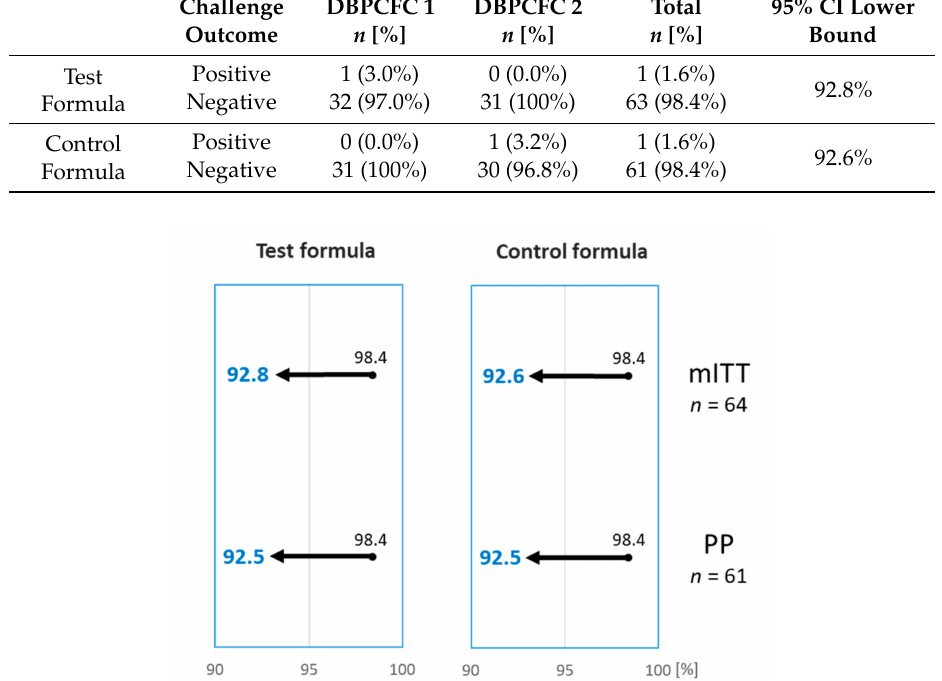
Figure 2. The percentage of subjects tolerating the Test and the Control formulas was 98.4%. Arrows indicate the 95% lower bound interval which was > 90% for both Test and Control formula, on the modified intention-to-treat (mITT) and per-protocol (PP) analysis, confirming hypoallergenicity according to the criteria set out by the American Academy of Pediatrics